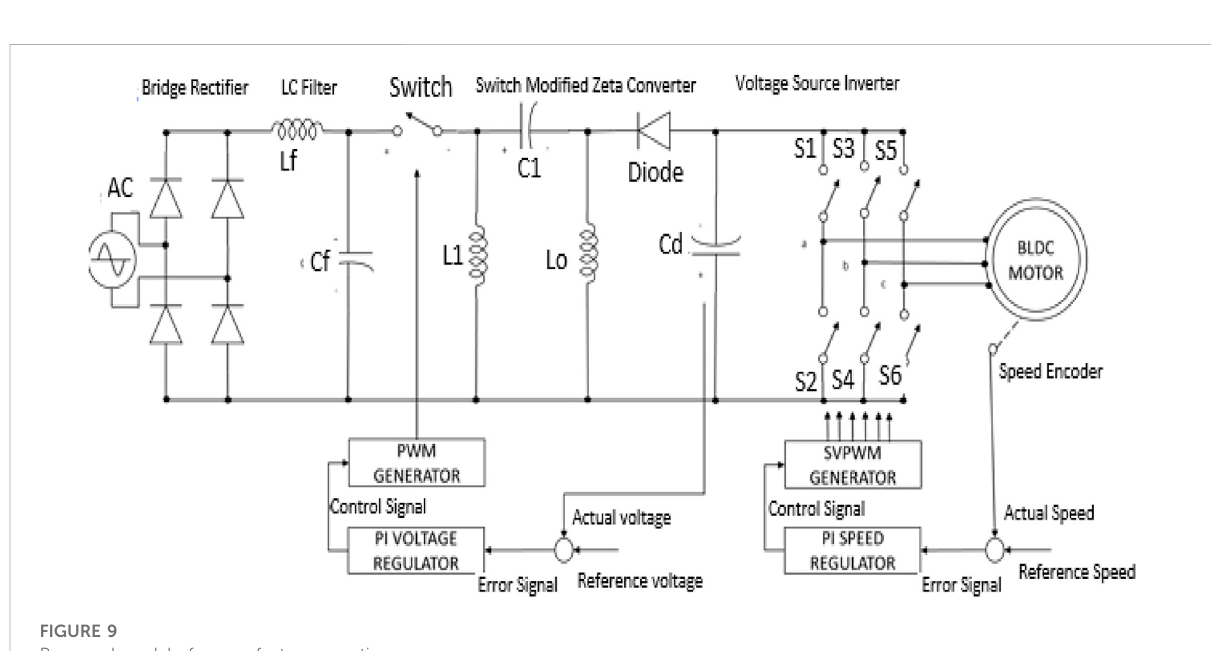
FIGURE 9 Proposed model of power factor